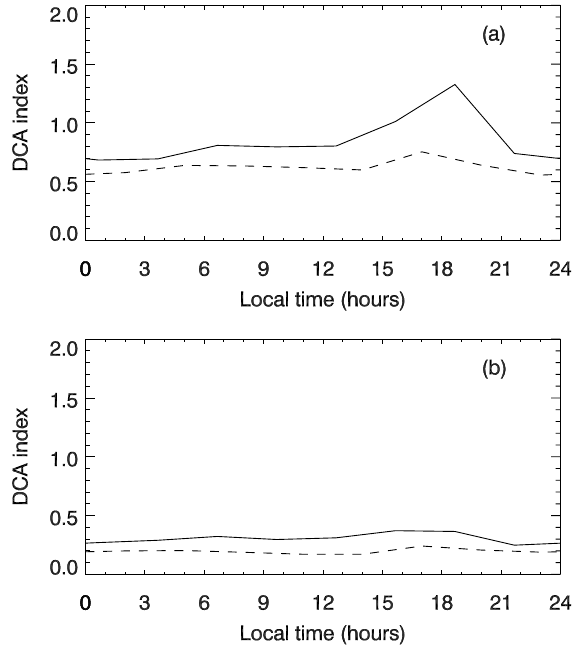
Fig. 8. Mean deep convection activity (DCA) index at (a) the Chiang-Rai and (b) the Pare Pare irregularity generating regions for September (solid line) and March (dashed